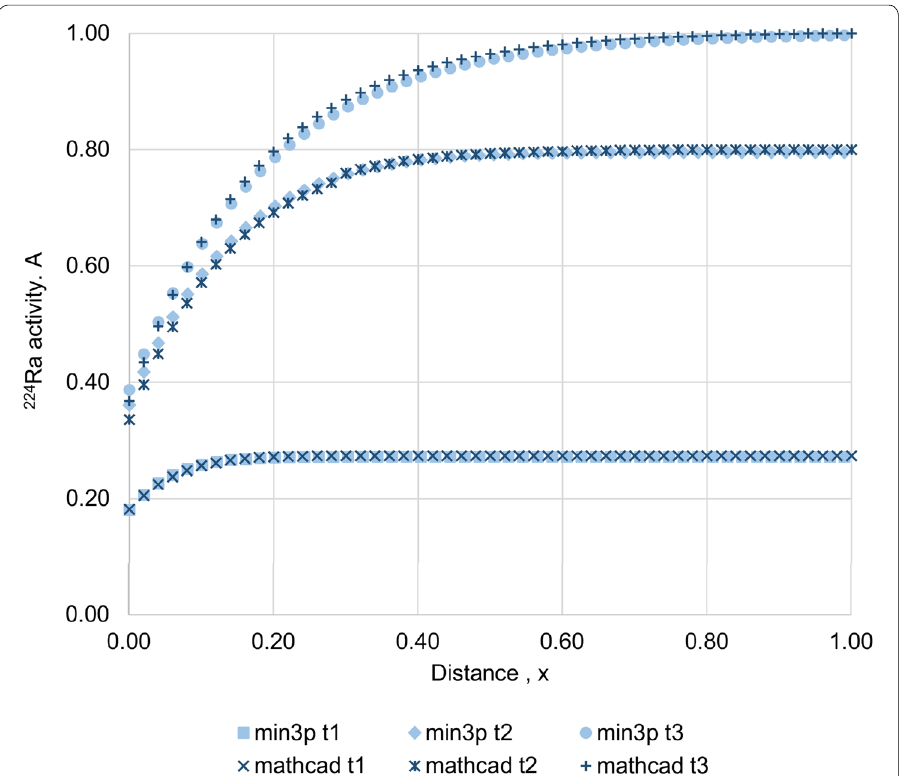
Fig. 7 Comparison of MIN3P and CAS model for one-dimensional transport of 224 Ra along a flow line, calculated at different half-lives ( t 1